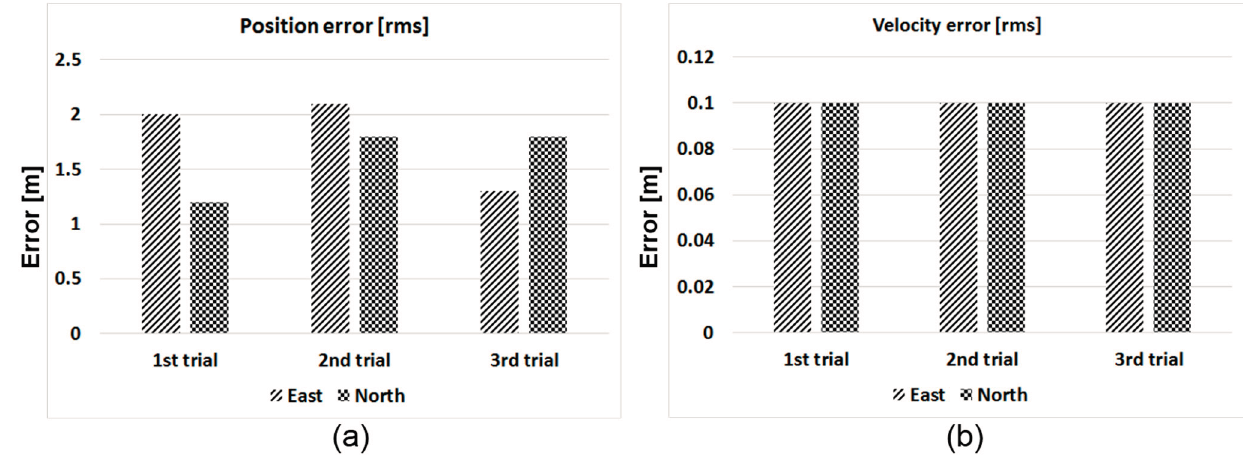
Figure 18. Performance analysis. ( a ) Horizontal error; ( b ) Horizontal velocity